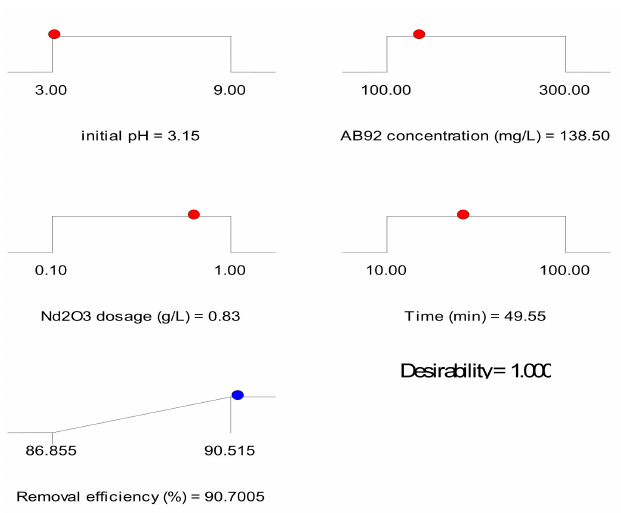
Figure 8. The desirability e ff ect for AB92 adsorption on Nd 2 O 3 nanoparticles.